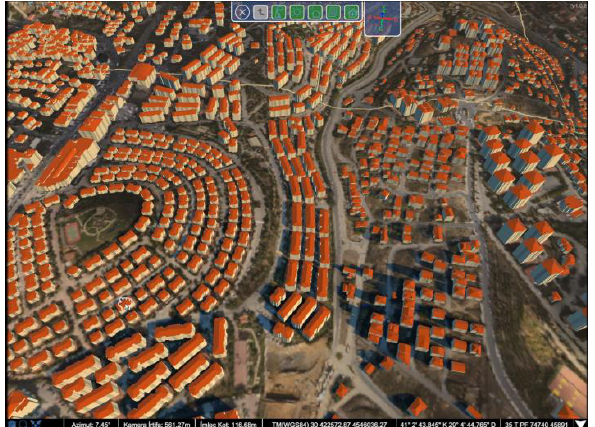
Figure 7. Default GUI view of Istanbul Solar Estimation.